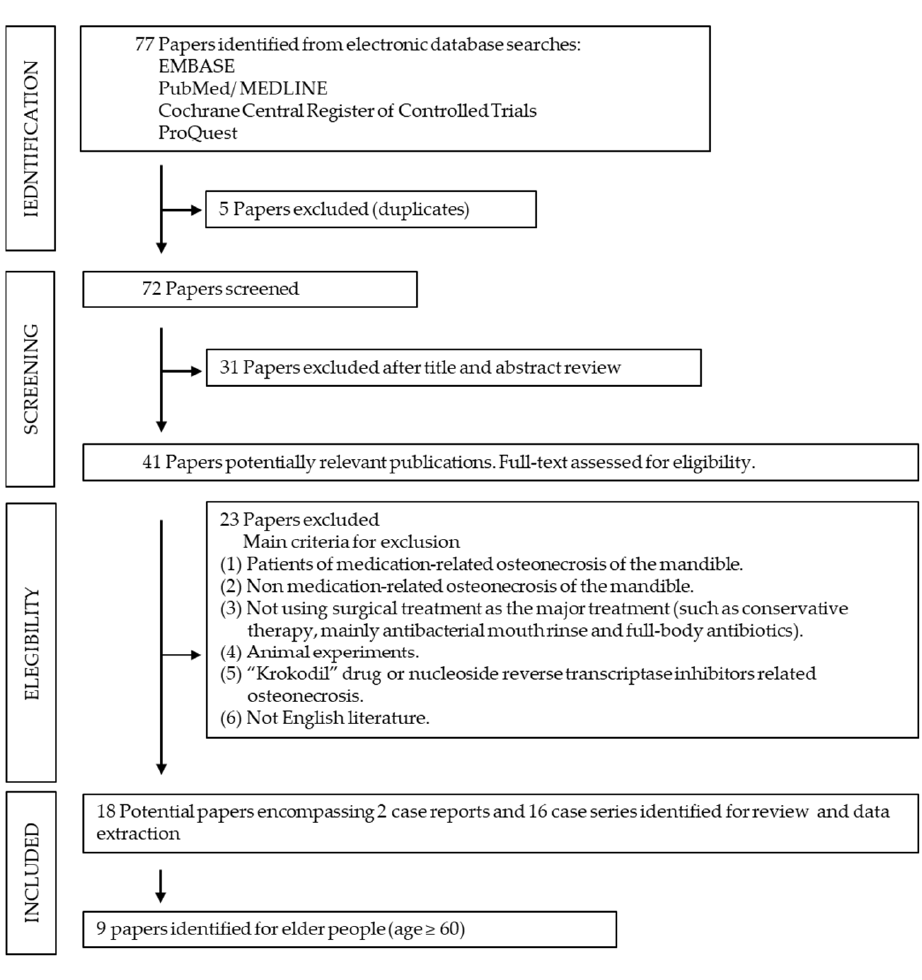
Figure 1. Process flow of study